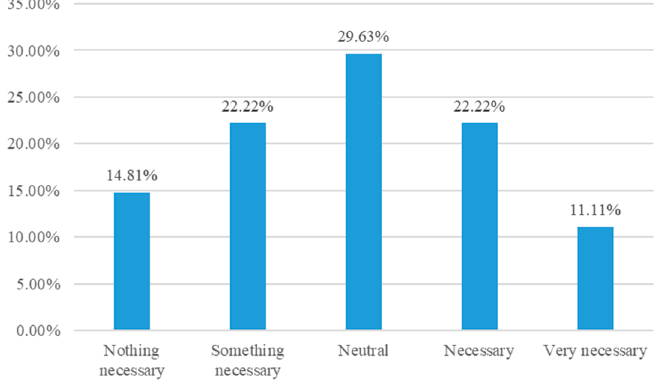
Figure 14. Assessment of whether networks need to be improved.